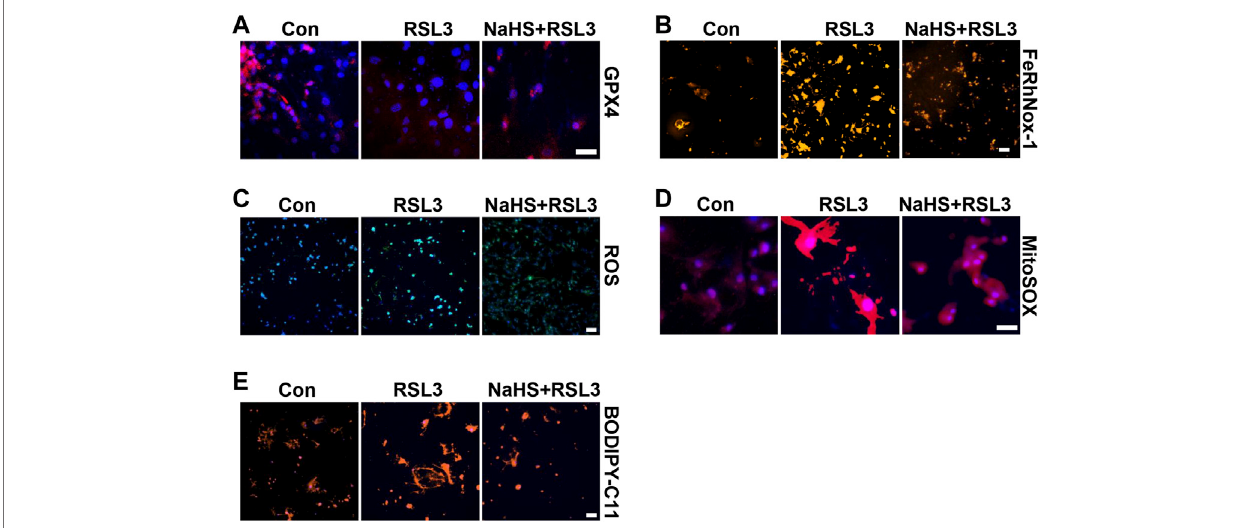
FIGURE 6 | CSE/H 2 S rescue RLS3-induced ferroptosis under HHP conditions. Under 200 mmHg conditions, HASMCs were pretreated with NaHS 24 h and followed by RLS3 treatment for another 6 h. Immuno fl uorescent staining of GPX4 (A) . HASMCs were incubated with the FeRhNOX-1 probe for measuring iron (B) . HASMCs were labeled with the ROS probe to detect cellular ROS (C) , MitoSOX Red to detect mitochondrial ROS (D) , and BODIPY-C11 to detect lipid peroxidation (E) by immuno fl uorescent staining. All scale bar = 50 μ M.